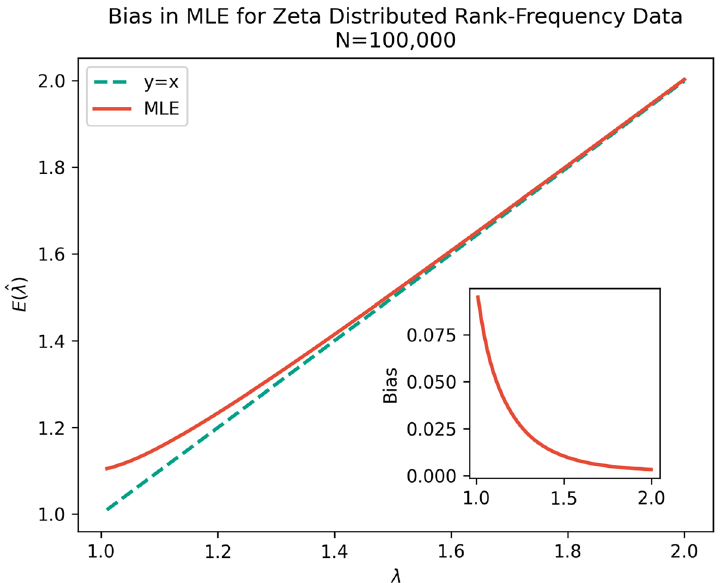
Figure 1. Bias in maximum likelihood estimation for rank-frequency data. 100 values of (cid:31) between 1 and 2 were investigated. For each (cid:31) , samples with N = 100, 000 were generated from an unbounded power law distribution and Clauset et al.’s estimator was applied to the empirical rank-frequency distribution. This was repeated 100 times and results averaged. There is a clear and strong positive bias for (cid:31) (cid:31) 1.5 .